Question: In a single sentence, describe what this figure presents.
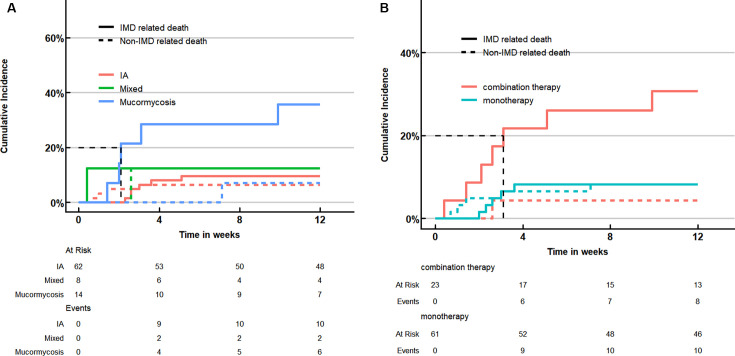
Answer: Cumulative incidence of IMD-associated mortality at week 12. ( A ) According to infection type (IA, mucormycosis, and mixed infection). ( B ) According to treatment strategy (monotherapy vs. combination therapy). Solid lines represent the cumulative incidence of IMD-associated mortality, and dashed lines represent non-IMD mortality as competing events. The risk tables display the number of patients at risk at weeks 0, 4, 8, and 12. Gray’s test P -values: ( A ) P = 0.04 for overall comparison among the three infection types. ( B ) P = 0.01 for monotherapy vs. combination therapy. IA, invasive aspergillosis; IMD, invasive mold disease.